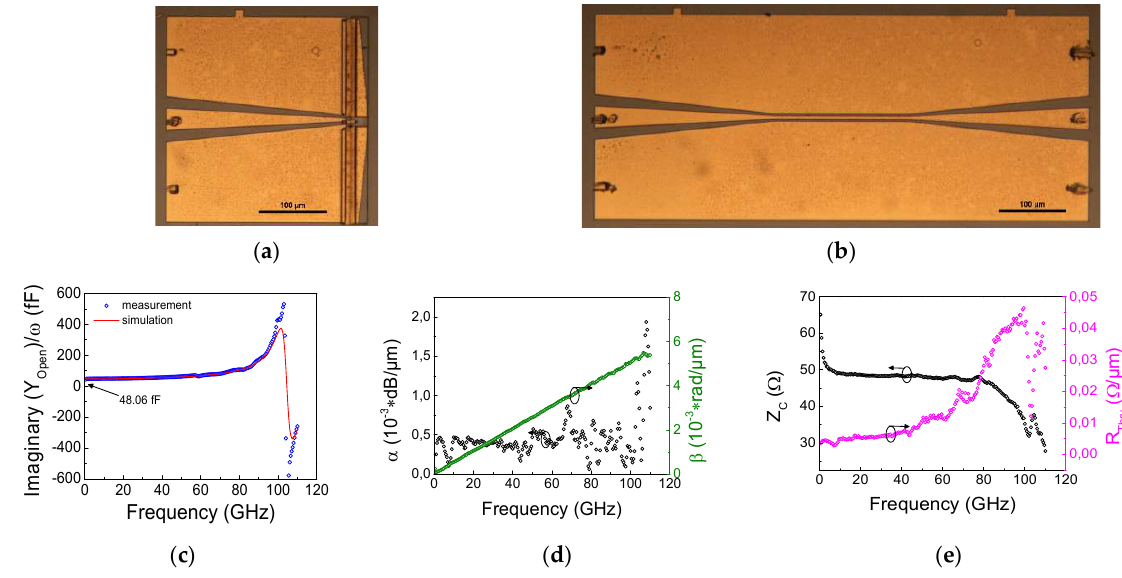
Figure 9. ( a ) Microscope image of the Open test structure; ( b ) microscope image of the Thru test structure; ( c ) extracted LC parasitics of the equivalent circuit for the InGaAs/InP UTC-PD Open test structure; ( d ) extracted attenuation constant α , and phase constant β of the Thru test structure; ( e ) extracted characteristic impedance, Z c , and calculated linear series resistance 𝑅 (cid:3021)(cid:3035)(cid:3045)(cid:3048) , of the Thru test structure. Table 4. Extracted RLC lumped element values from InGaAs/InP UTC-PD Open and Thru test structures.